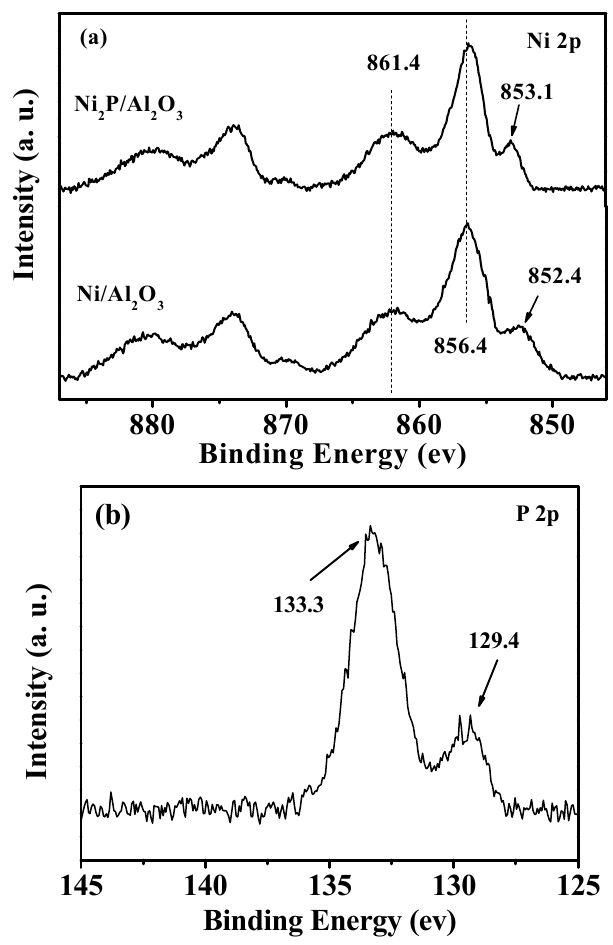
Figure 3. X-ray photoelectron spectroscopy (XPS) spectra of the Ni 2p ( a ) region for the Ni/Al 2 O 3 and Ni 2 P/Al 2 O 3 catalyst and P 2p ( b ) for the Ni 2 P/Al 2 O 3 catalyst.